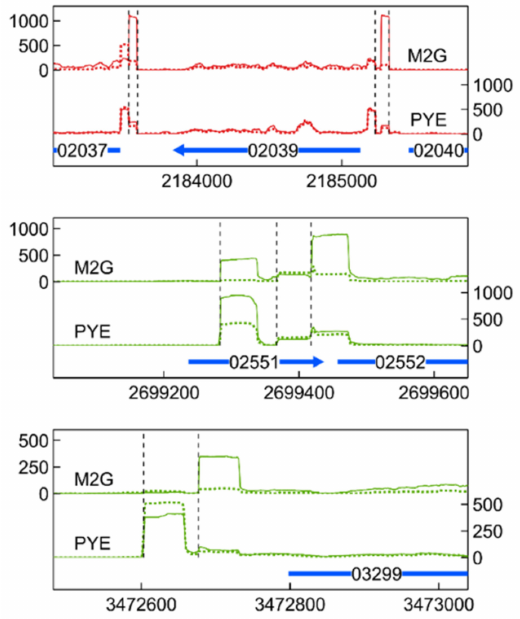
Figure 10. Transcription profile of identified alternative TSSs for selected genes. Combined TSS read counts of the three biological replicates of Cu-exposed (solid line) and unexposed (dotted line) stalked cells in M2G (upper) and PYE (lower) medium are shown for the positive (green) and negative (red) strand. Coding sequences are represented by a horizontal blue arrow (number is CCNA_ locus tag, x axis positions being the genomic location). Detected TSSs are indicated with a vertical dashed